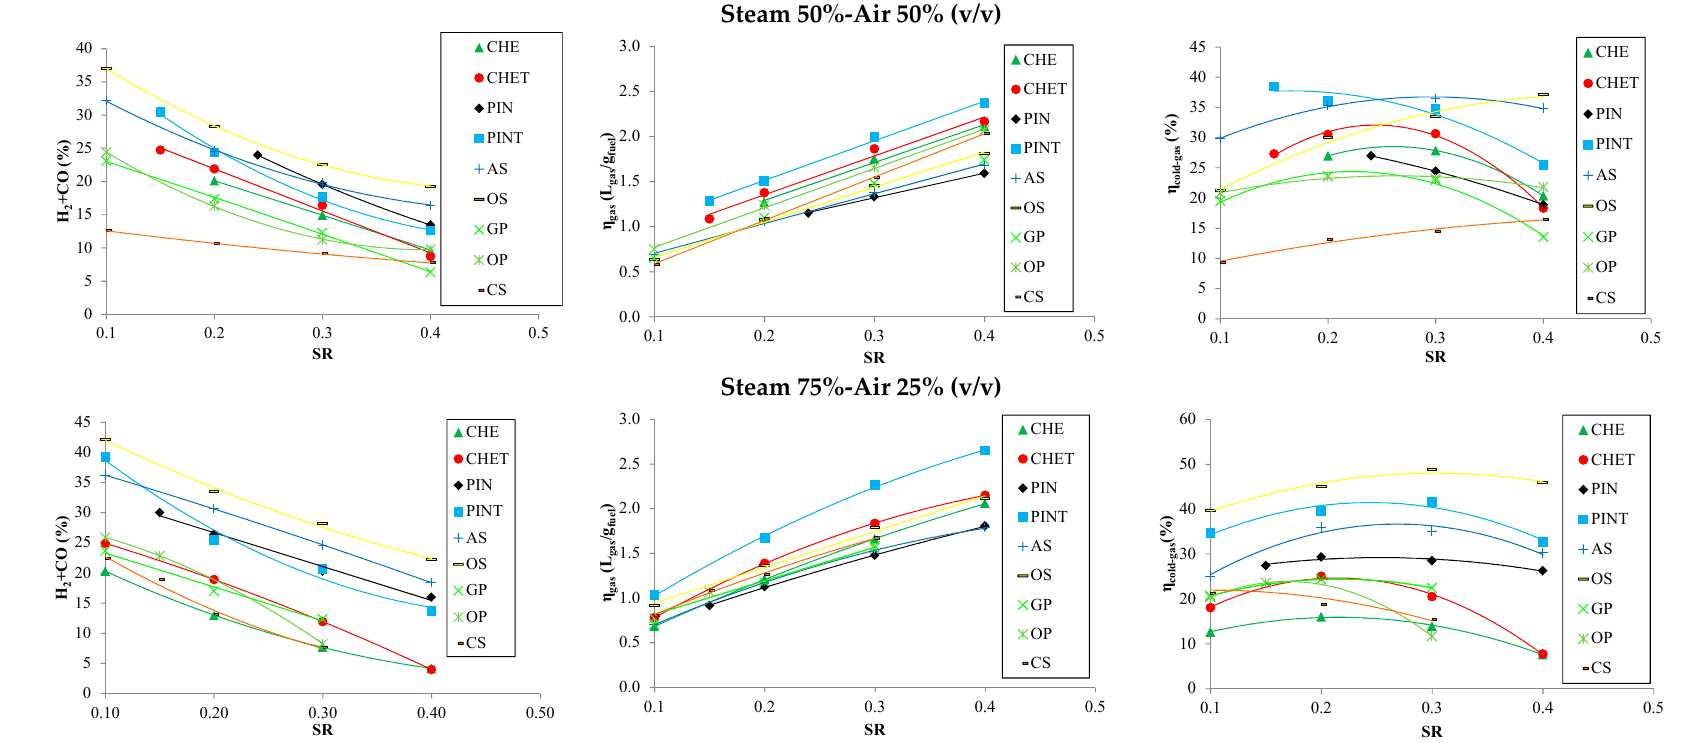
Figure 3. Comparison of the obtained results (H 2 + CO emissions, gas yield (L gas /g fuel ) and cold-gas efficiency (%)) at the selected steam/air ratios (50/50 and 75/25) vs. SR.